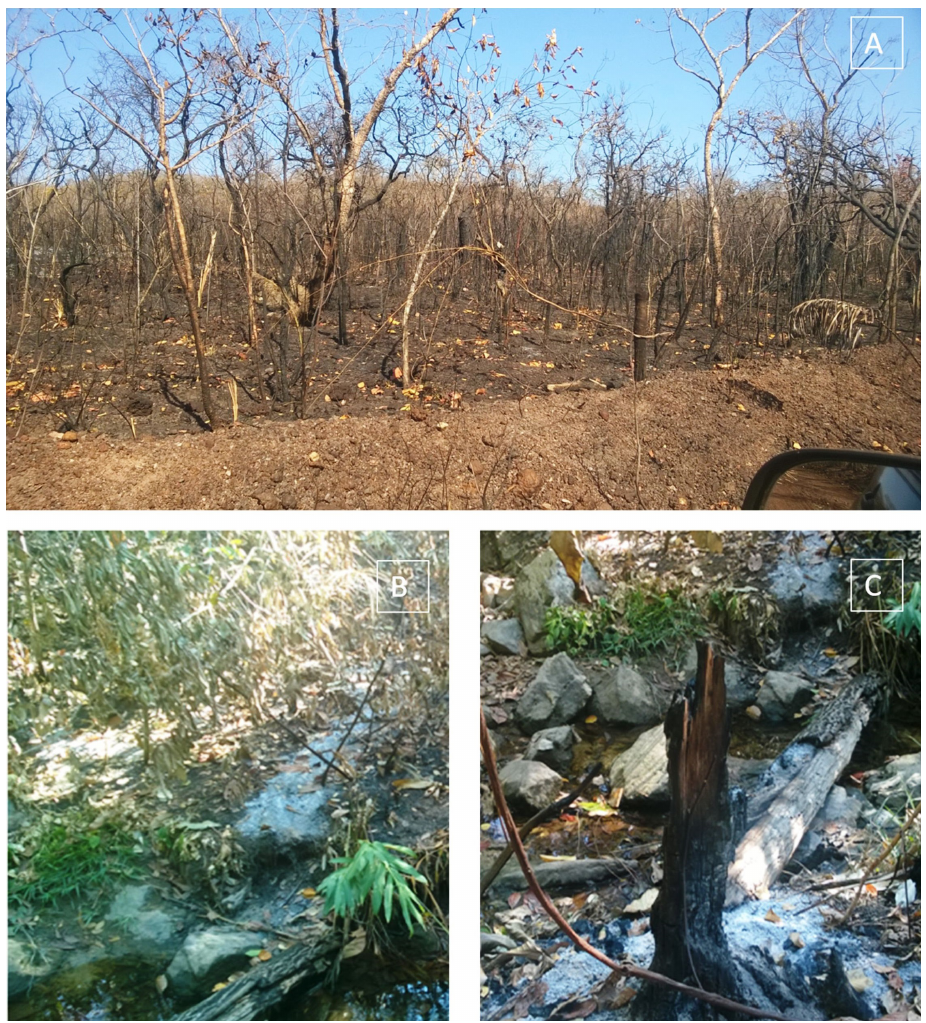
Figure 1. Post-fire condition of vegetation in an adjacent area (A) and into the riparian zone (B and C) of a stream in an ecotone between Cerrado and Tropical Rain